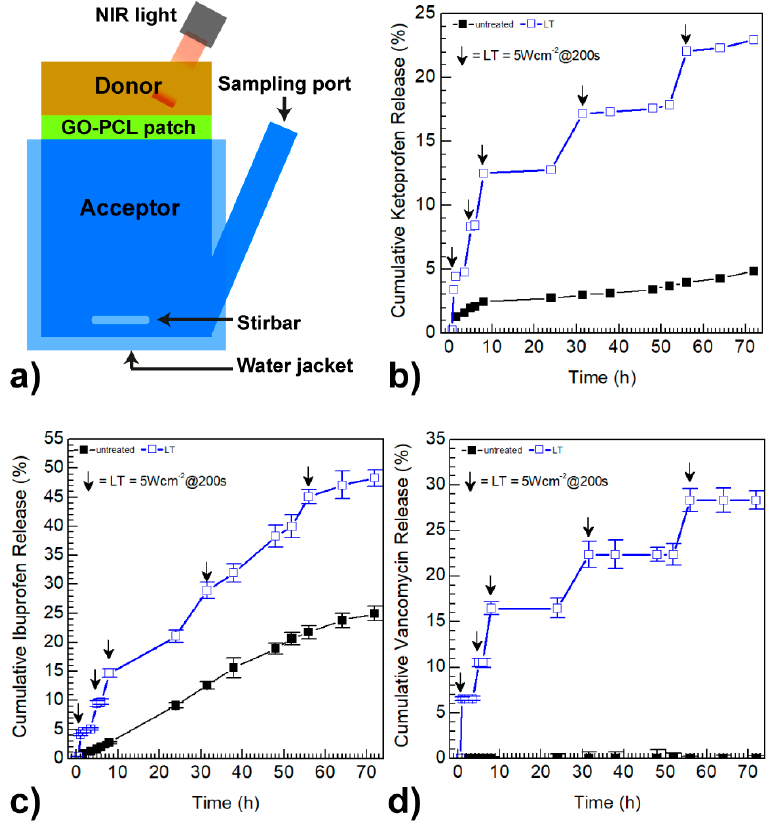
Figure 4. Schematization of a Franz cell used for drug release studies ( a ). Ketoprofen ( b ), ibuprofen ( c ) and vancomycin ( d ) release profiles of the drug loaded GO–PCL patches in PBS pH 7.4 after five cycles of near infrared (NIR) photo-stimulation: each arrow indicates the exposure to an 810 nm laser diode for 200 s and a power density of 5 Wcm − 2